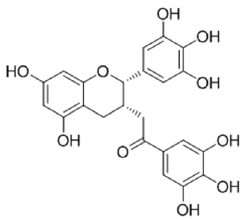
Figure 32. Structure of epigallocatechin-3-gallate.